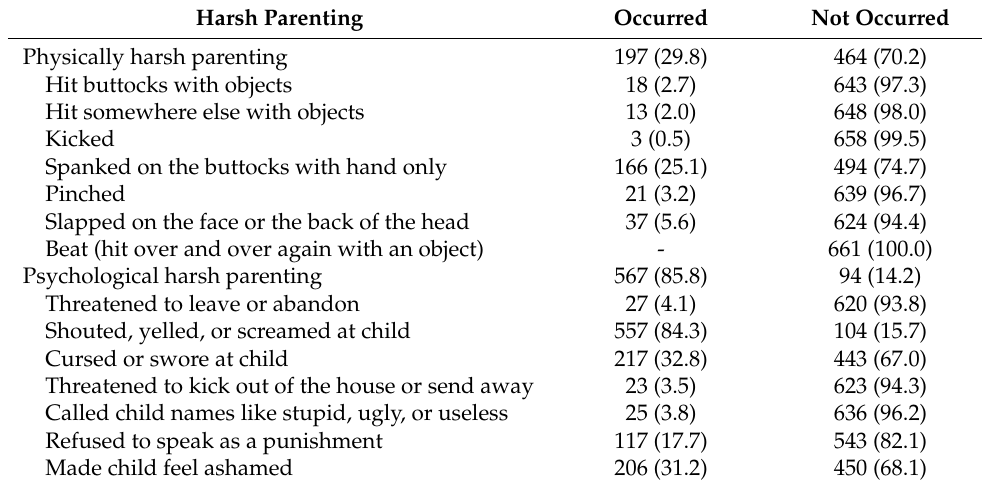
Table 2. Measures of harsh parenting in the last year, N (%). Harsh